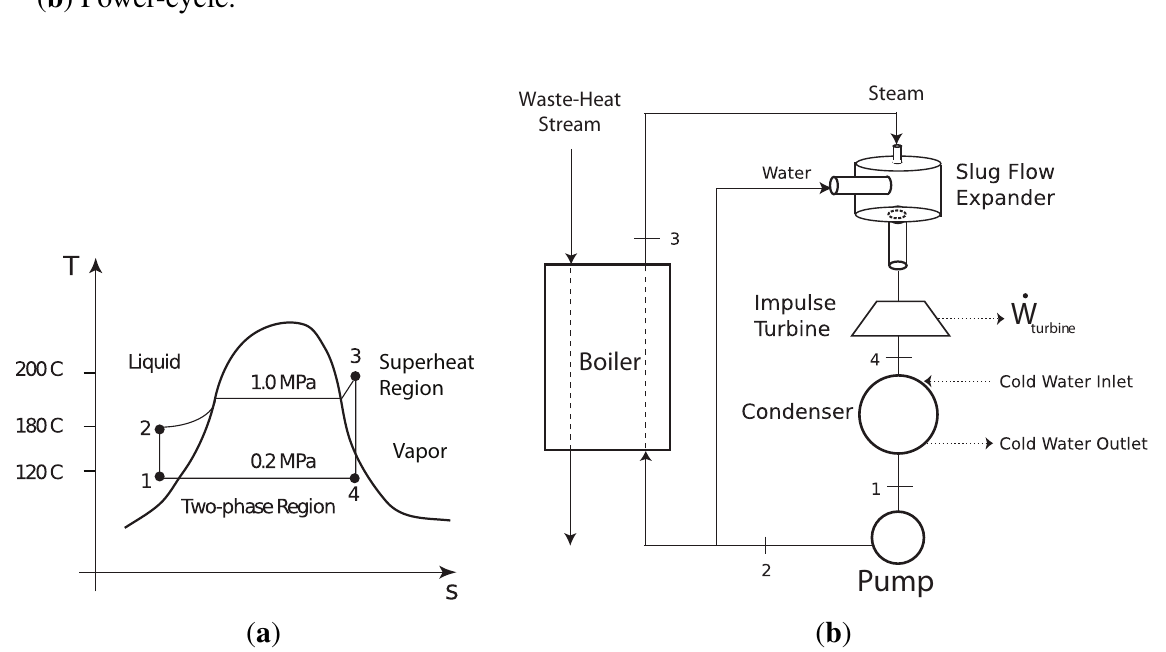
Figure 4. Proposed thermal cycle with slug flow expander. ( a ) Temperature-entropy diagra; ( b )